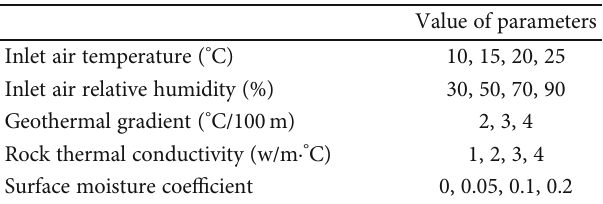
Thermal conductivity of the rock (W ·(m· ° C) − 1 ) Note: the solid line is the heat transfer, and the dotted line is the air temperature. Figure 11: E ff ect of rock thermophysical properties on the air temperature at the shaft bottom. Table 1: The calculating parameter